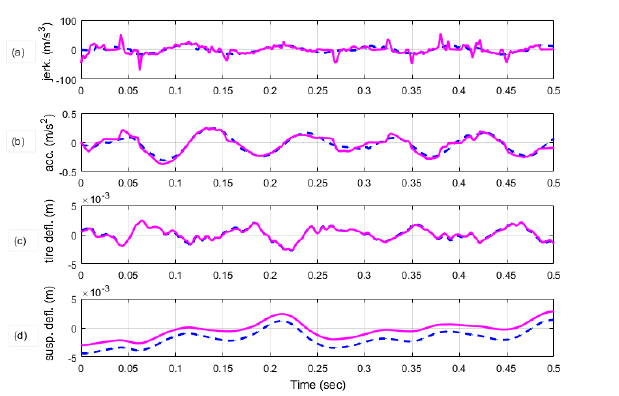
Figure 5. ( a – d ) Time responses of the semi-active system with 0.1 s preview time on asphalt road input using (i) 1st weighting sets: – – – – ; (ii) 2nd weighting sets: ——–